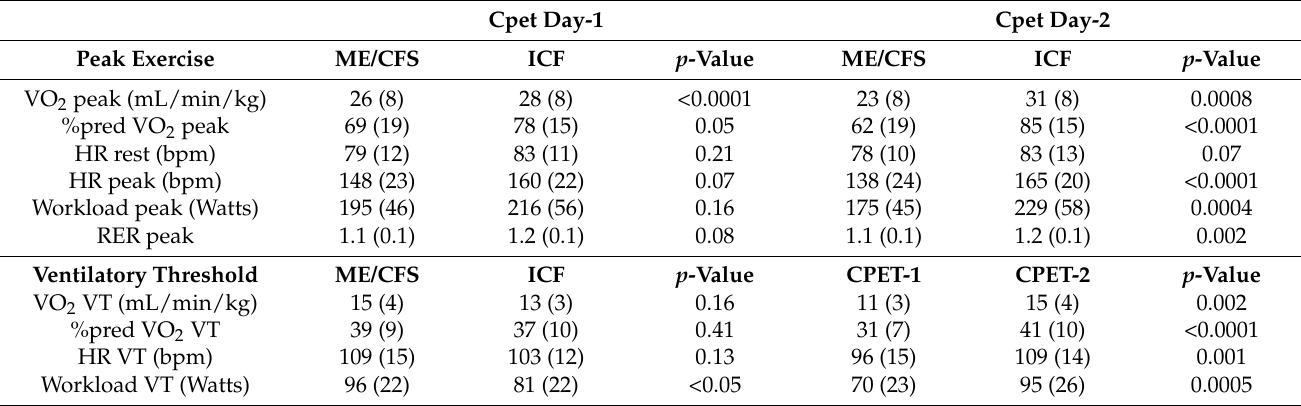
Table 3. CPET-1 variables in ME/CFS compared to ICF males (left side) and CPET-2 variables in ME/CFS compared to ICF males (right side).